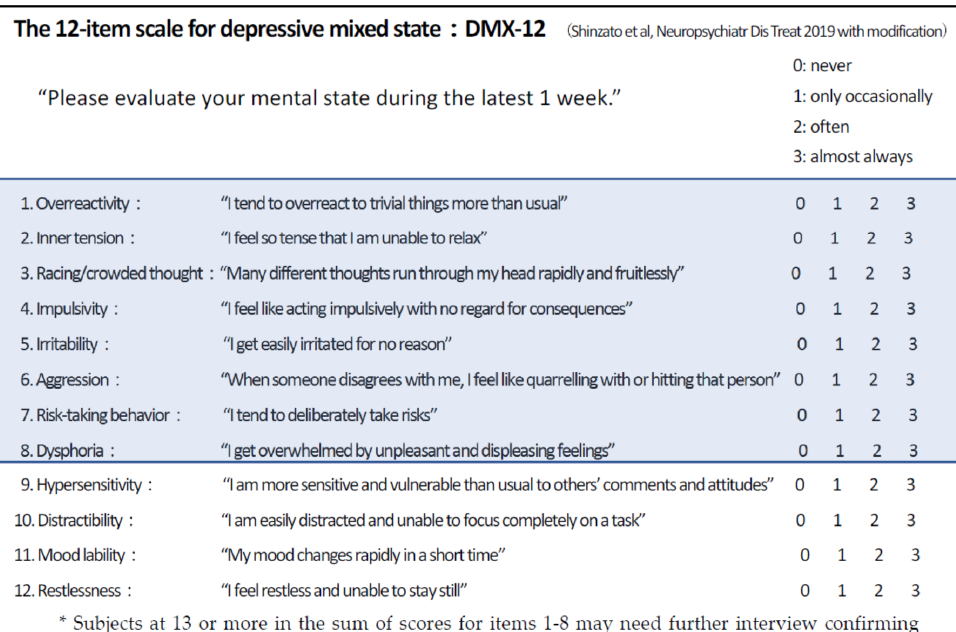
Figure A2. The 12-item questionnaire for quantification of depressive mixed state in